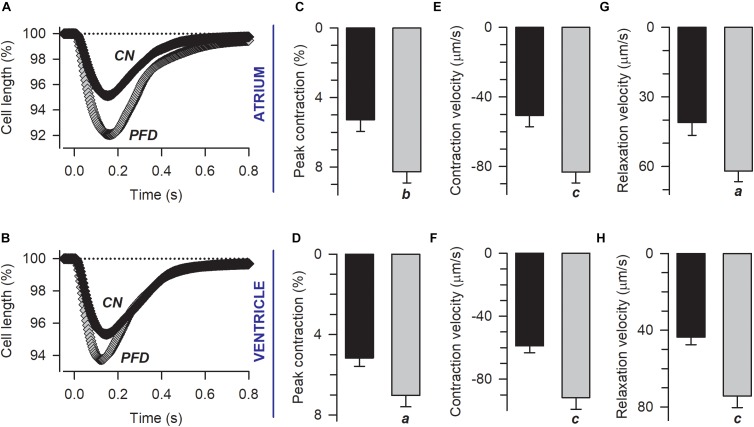
Pirfenidone improves the contractility of cardiac myocytes. (A,B) Electrically evoked contractions from atrial (A) and ventricular (B) myocytes previously kept in culture under either control (CN) or PFD conditions (PFD). Plotted are mean values that were estimated from a total of 56 atrial (30 CN, 26 PFD) and 110 ventricular (59 CN, 51 PFD) myocytes. The corresponding average values (mean ± SEM) of peak cell shortening (C,D) and the maximum speed of contraction (E,F) and relaxation (G,H) are also shown. Black and gray symbols/bars indicate control and PFD-treated cells. ap < 0.01, bp < 0.005, cp < 0.001.